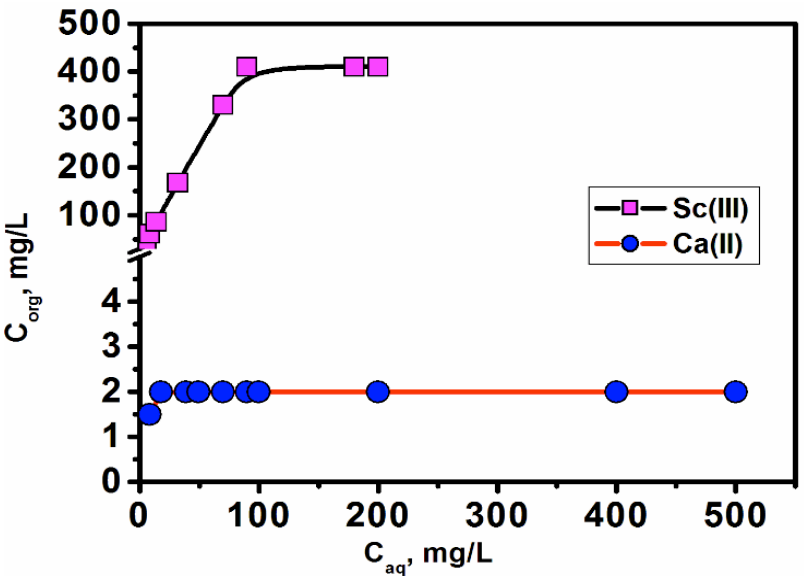
Figure 6. The isotherms of scandium and calcium extraction by Cyanex 272 extractant dissolved in kerosene: pH = 1.8; O/A 1:1; 0.025 M Cyanex 272; extraction time 10 min; 25 ± 1 °C. Table 2. Comparison of the capacity of different extractants with Cyanex 272 for the extraction of scandium.